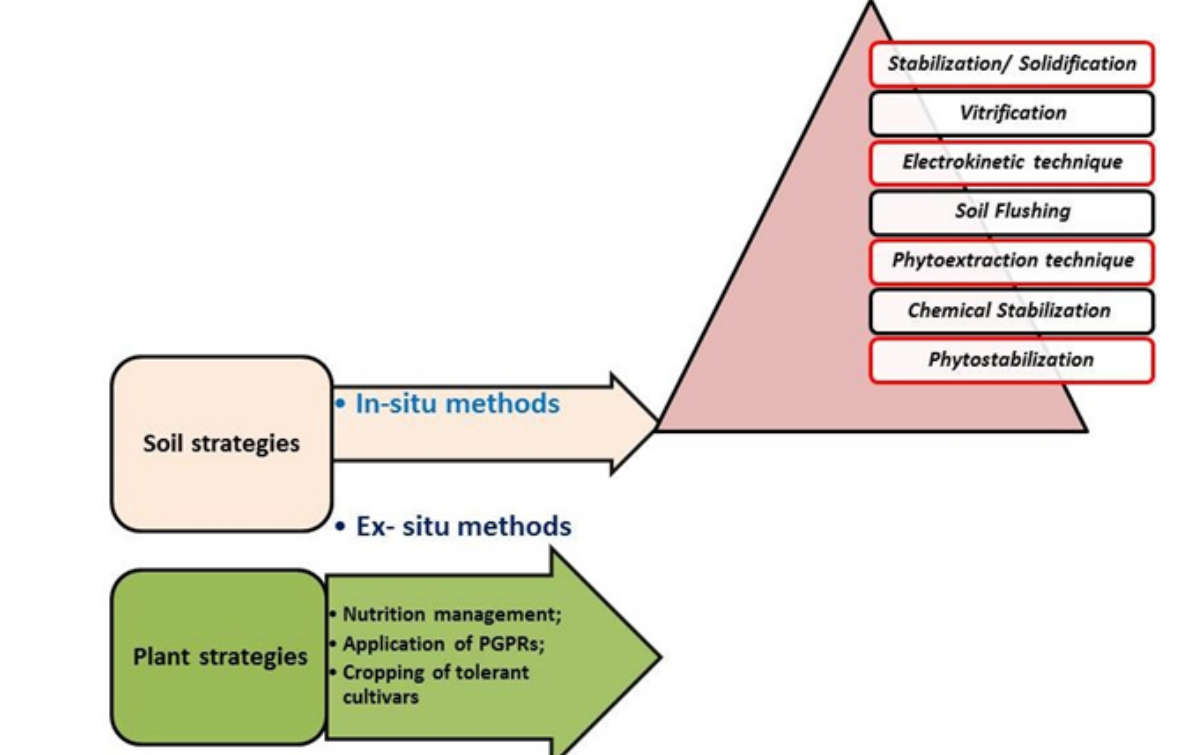
Figure 3. Remediation techniques for heavy metals in contaminated